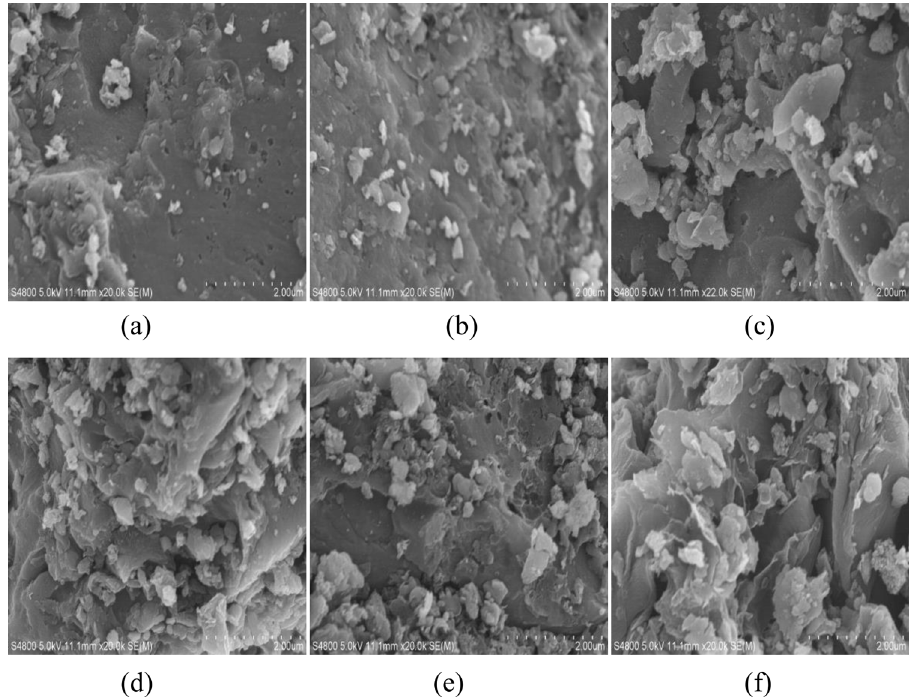
Figure 8: Scanning electron microscopic photos of surface modi fi ed TiO 2 : ( a ) unmodi fi ed TiO 2 , ( b ) 5% KH570, ( c ) 10% KH570, ( d ) 15% KH570, ( e ) 20% KH570, and ( f ) 25% KH570.